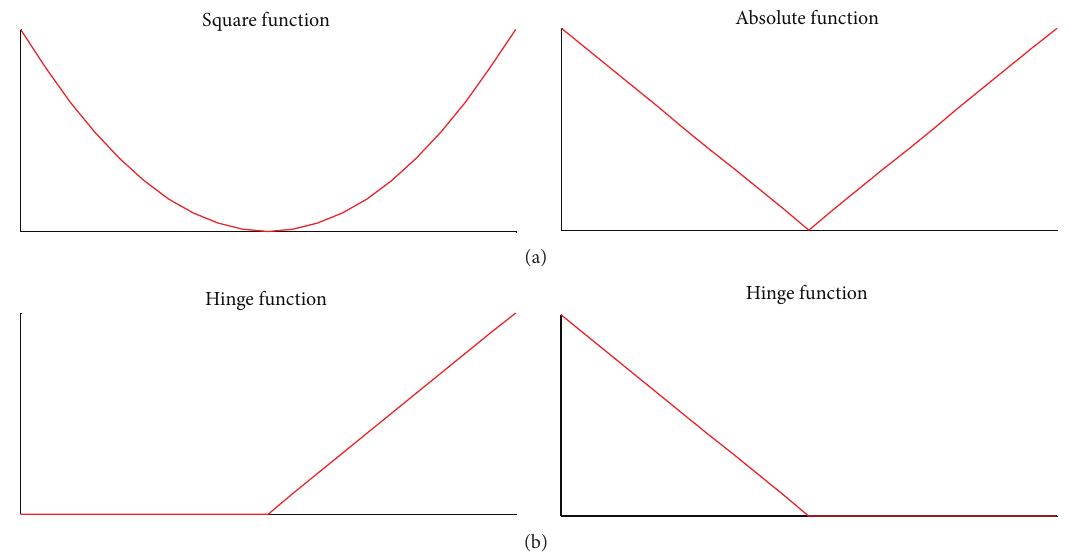
Figure 1: Two different distance functions and hinge functions. The top plane shows the two different distance function. The bottom plane shows that the absolute function | x | can be decomposed into two hinge functions [ x ] + and [− x ] +